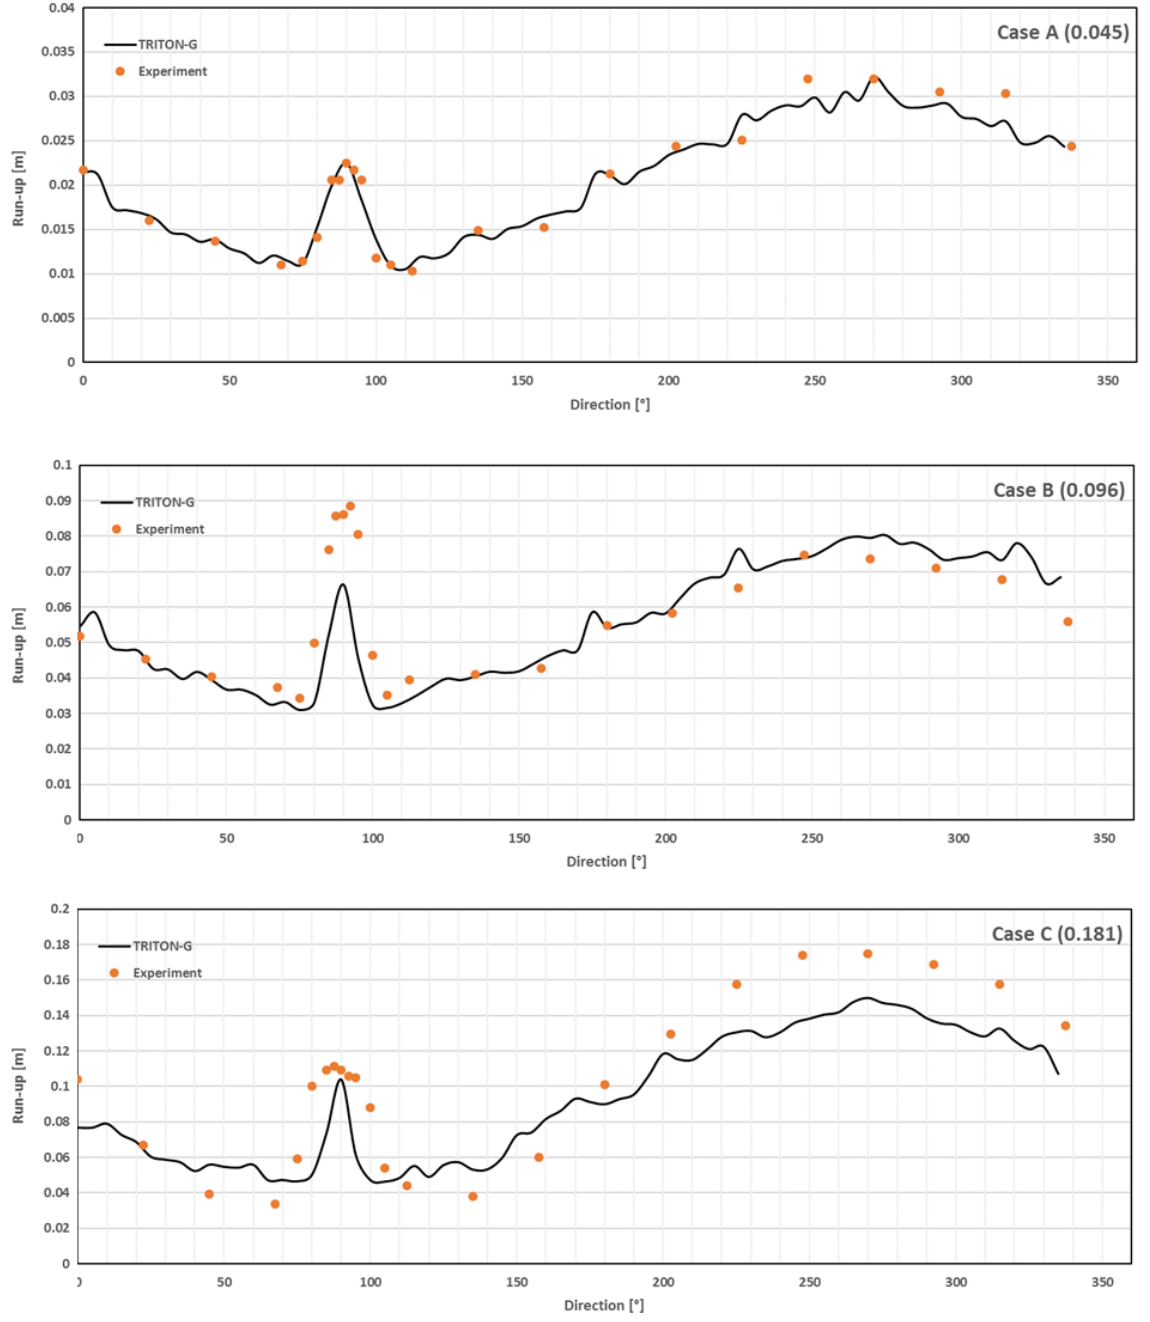
Figure A10. Comparison between computed and measured run-up around the island for the three